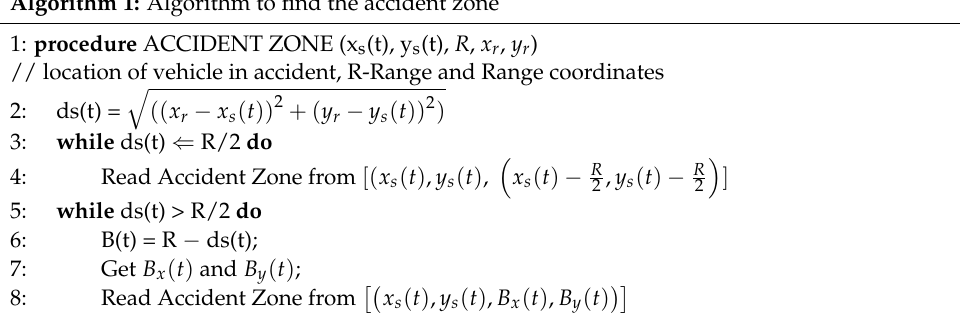
Algorithm 1: Algorithm to find the accident